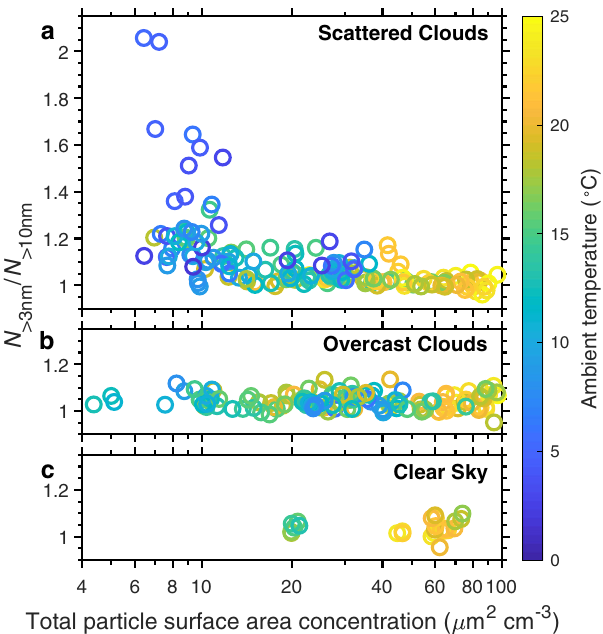
Fig. 2 Key factors driving new particle formation in the marine boundary layer (as indicated by elevated N >3nm / N >10nm ). Dependence of N >3nm / N >10nm on total particle surface area concentrations and ambient temperature is shown under different cloud conditions during the ACE-ENA campaign. These conditions include: a scattered clouds (cloud fraction between 0.3 and 0.85); b overcast conditions (cloud fraction over 0.85), and c clear sky (cloud fraction below 0.3). The cloud fraction is determined from the measurement of a total sky imager at the ENA site. Each data point represents the average of measurements within an altitude bin of 200 m inside the marine boundary layer during the vertical pro fi les by the G-1 aircraft. Source data are provided as a Source Data fi le.